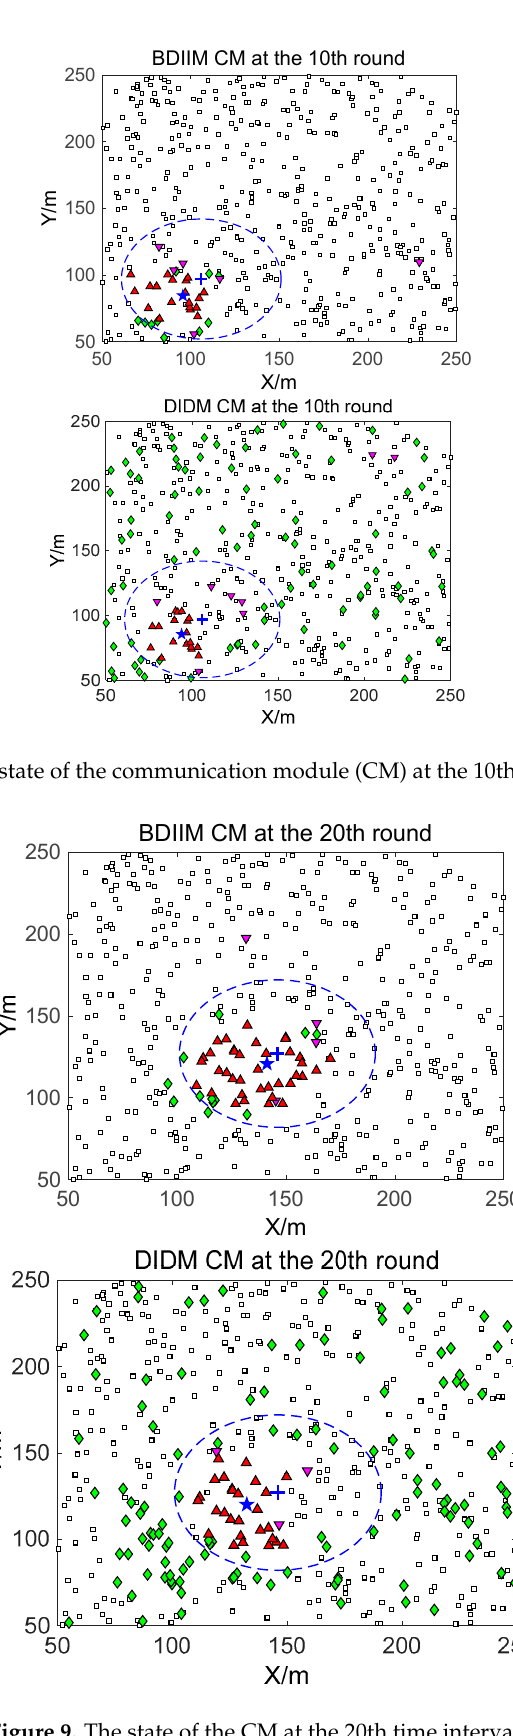
Figure 10. The state of the CM at the 30th time interval. Further, the detailed data regarding the DIDM method and the proposed BDIIM method are curved, as shown in Figures 11 and 12. The dashed (blue) and solid (pink) lines represent the DIDM method and the proposed BDIIM method, respectively. The WC performance of the SMs is shown in Figure 11. The detailed calculation data are listed in Table 5. It can first be seen from Figure 11b that, throughout the whole process, there is little difference in the number of valid waked SMs between the two methods. However, it can be clearly seen from Figure 11a that the number of waked SMs via the BDIIM method is fewer than that achieved via the DIDM method throughout the whole process, especially after 20 s. The ratio of the number of valid waked SMs to the total number of waked SMs is given in Figure 11c. The average ratio via the proposed method in this work approaches 0.38, while